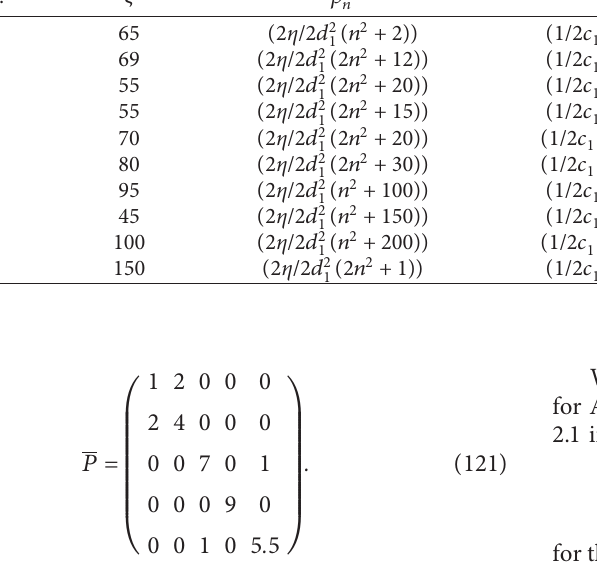
Table 3: Computed results for Algorithm 2.1 in [20] with the different parameters. Test